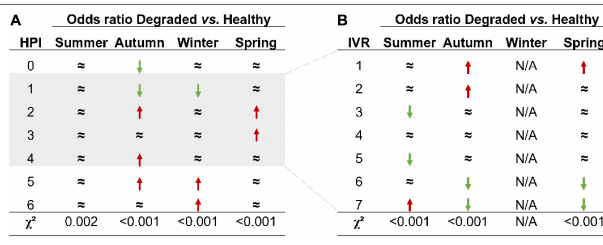
TABLE 1 | Ratio test for the odds of each (A) herbivory pressure index (HPI) and (B) invertebrate/vertebrate ratio (IVR) category on degraded vs. healthy golden kelp